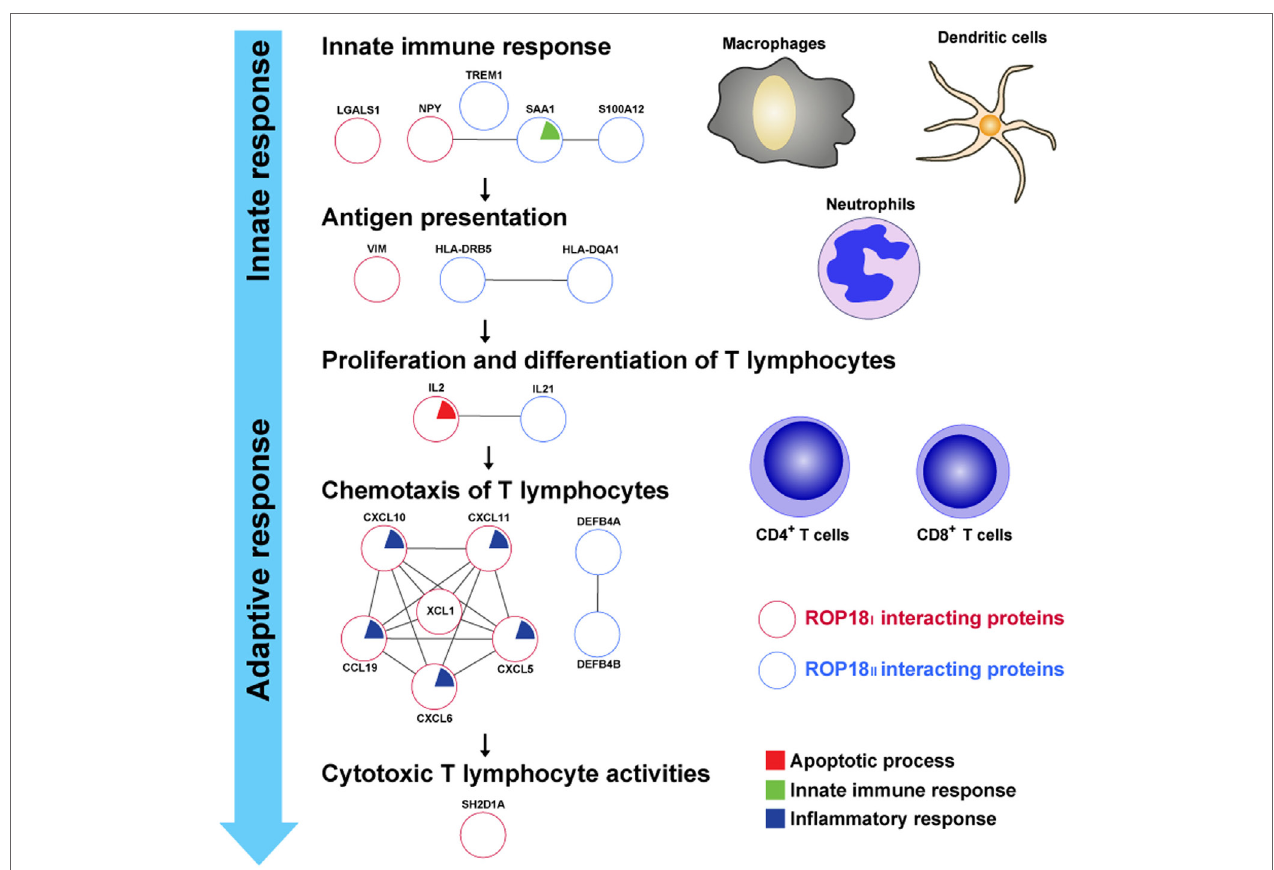
FigUre 7 | Tg ROP18-interacting proteins involved in the immune response. Numerous ROP18 I (red circles) and ROP18 II (blue circles) identified interacting proteins related to the processes of immune response. During T. gondii infection, innate immune response acts rapidly to provide the first line of defense and activate the adaptive immune response, with release of proinflammatory cytokines by macrophages, dendritic cells, and neutrophils. In the milieu of proinflammatory cytokines, T cell-mediated immune response is initiated when naïve CD4 + or CD8 + T cells encounter the parasite antigens presented by antigen presenting cells (APCs). Once the antigen-specific T lymphocytes are activated, they proliferate, differentiate, and traffic to the sites of infection, protecting the host by exhibiting cytotoxic T lymphocyte (CTL) activities toward infected